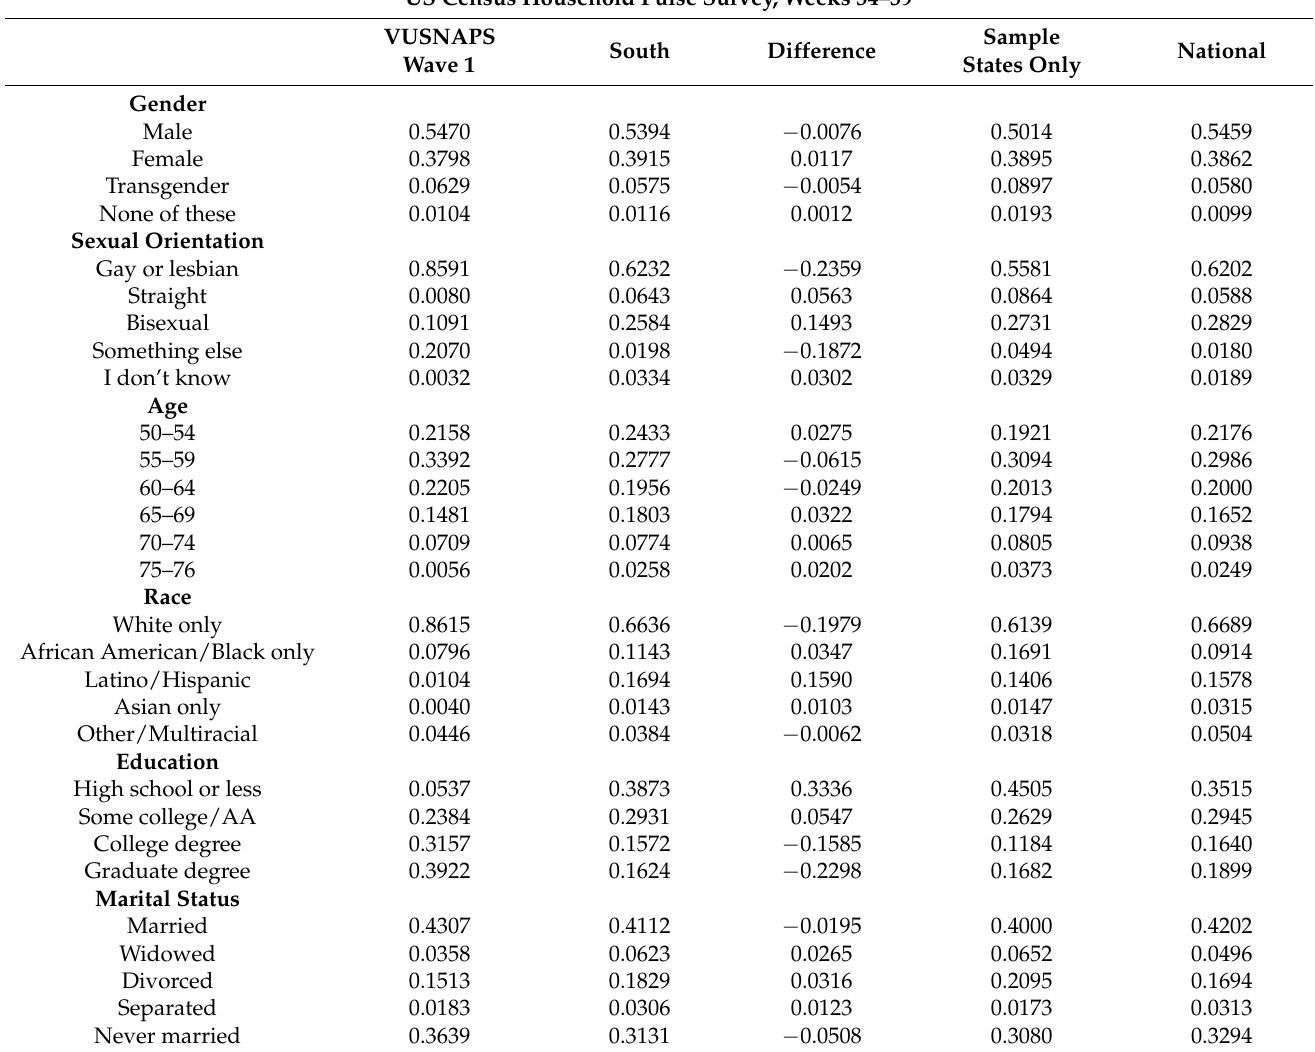
Table A1. Comparison of VUSNAPS Sample Characteristics with Census Household Pulse Survey Estimates for LGBT Adults Aged 50–76 in